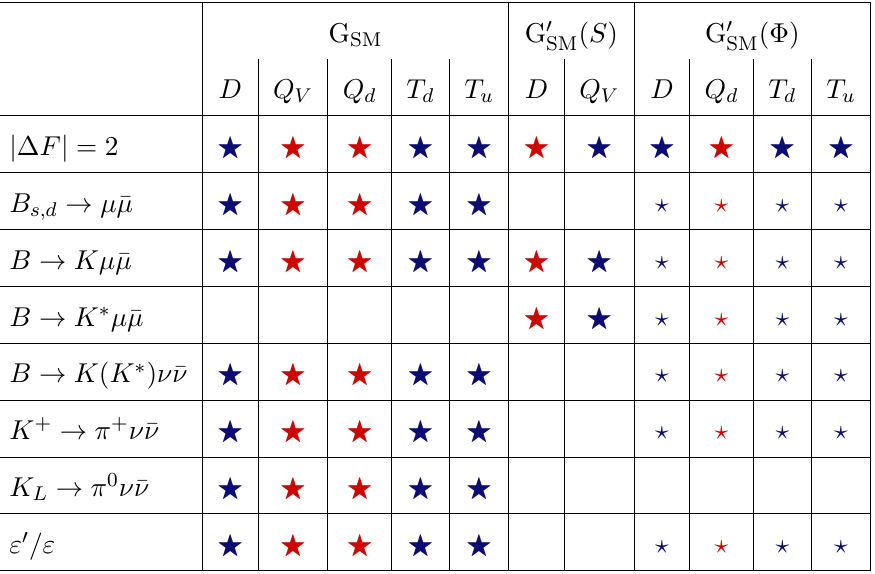
Table 7. \DNA" of (cid:13)avour e(cid:11)ects in VLQ models. A star indicates that signi(cid:12)cant e(cid:11)ects in a given model and given process are in principle possible, but could be reduced (see section 6) through correlation among several observables. Empty space means that the given model does not predict sizeable e(cid:11)ects in that observable. The star F indicates left-handed currents and the star F right-handed ones, smaller stars indicate the suppression of transitions of B mesons, respectively. Since only the relative phases of the (cid:21) VLQ